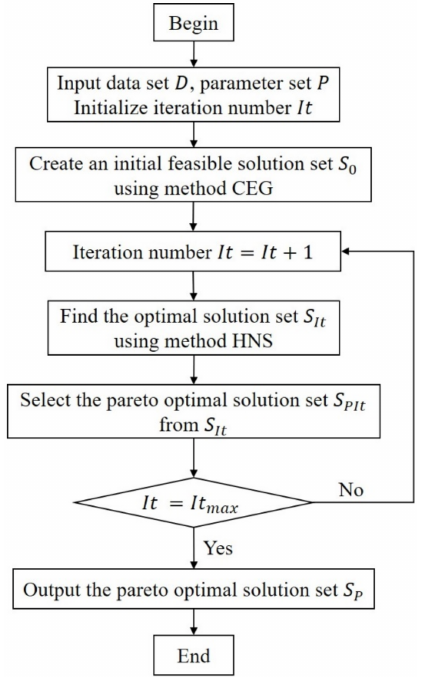
Figure 5. The overall flowchart of heuristic